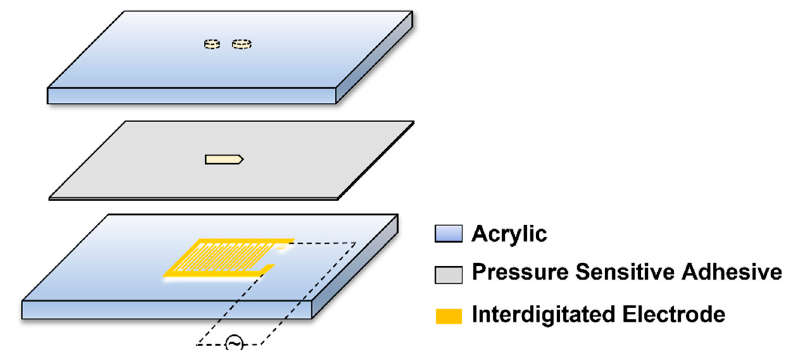
Figure 1. Schematic of the microfluidic chip.